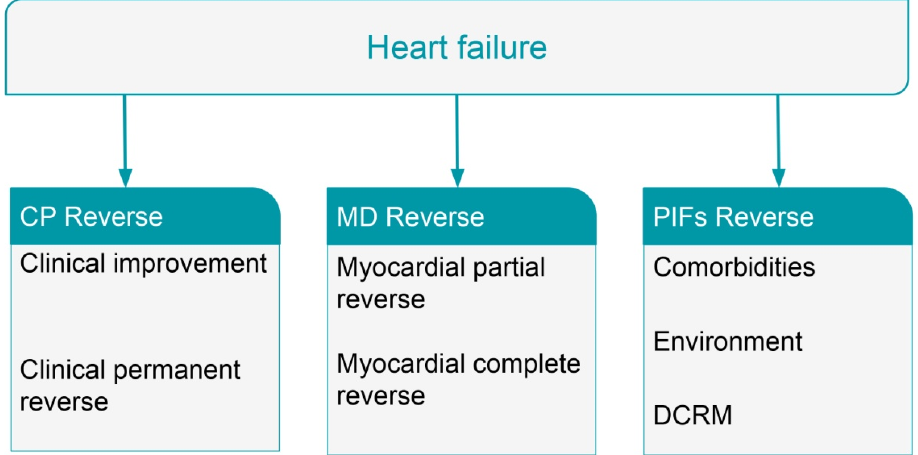
Figure 5. Potential reverse (partial or complete) of heart failure (HF) at the level of clinical phenotype (CP) or myocardial dysfunction (MD) or Phenotype Influencing Factors (PIFs). DCRM = disease compensatory regulatory mechanisms.